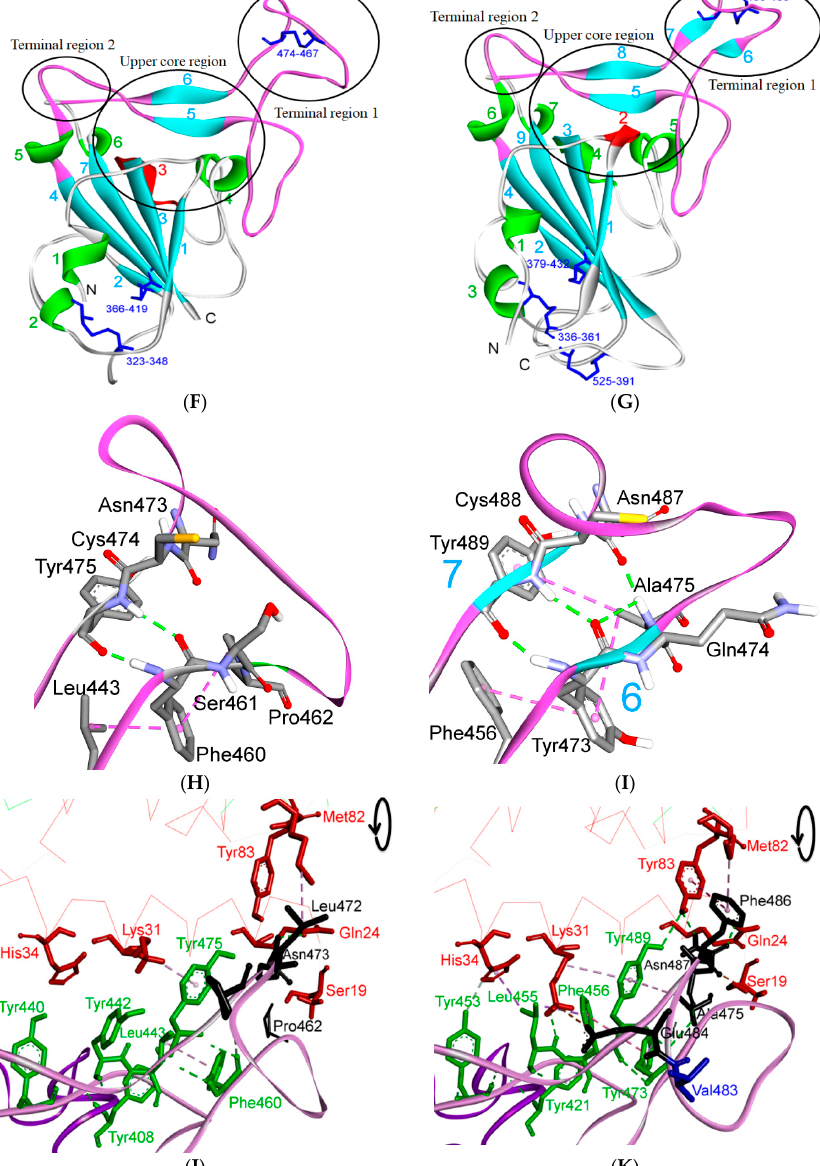
Figure 4. The aligned secondary structures of MERS-CoV, SARS-CoV and SARS-CoV-2, their distribution in the 3D structure and their influence on the binding contacts, and interactions with TR1. ( A – C ) are secondary structures of MERS-CoV, SARS-CoV and SARS-CoV-2, respectively. Disulphide bonds are represented by lines, and the sequences after the red and cyan stars in Figure 4A have been removed to keep the alignment formats with SARS-CoV-2. ( D ) The X-ray models of MERS-CoV (blue, PDB ID: 4L72), SARS-CoV (green, PDB ID: 2AJF) and SARS-CoV-2 (red, PDB ID: 6LZG) are structurally aligned. ( E – G ) show the 3D structures of MERS-CoV, SARS-CoV and SARS-CoV-2, respectively. ( H , I ) show parts of the RBM for both SARS-CoV and SARS-CoV-2, respectively. The influence of the di ff erences in TR1 on the intermolecular contacts and on binding contacts with ACE2 is shown in ( J ) for SARS-CoV and ( K ) for SARS-CoV-2. In these diagrams, amino acids shown in green represent a hydrophobic pocket (preceding TR1) that shows slight di ff erences between SARS-CoV and SARS-CoV-2. These di ff erences may a ff ect binding in this region (i.e., binding with Lys31 from ACE2) [6]. In all figures, β sheets, α -helices, and 3 / 10-helices are shown in cyan, green and red, respectively. Numbers in ( E – G , I ) indicate the order of secondary structures (i.e., β -sheets, α -helices, and 3 / 10-helices) in the S protein 3D